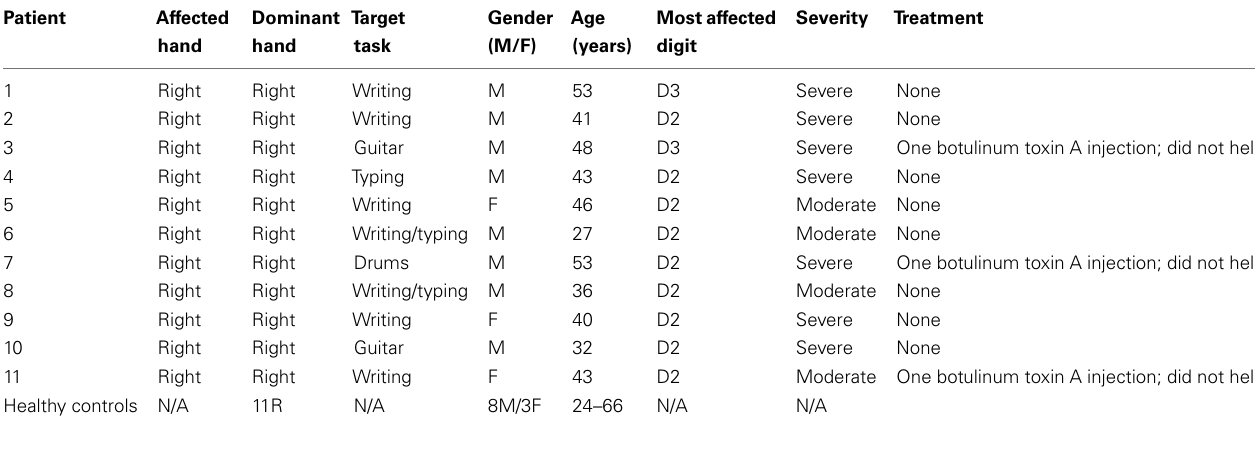
Table 1 | Description of subjects with task-specific focal hand